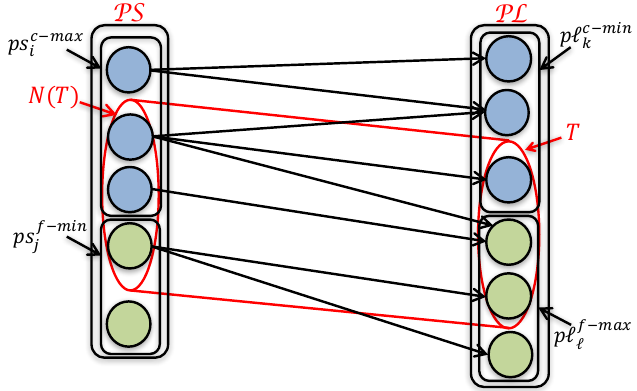
Figure 11. Illustration of a subset T of power loads and set N ( T ) of power sources.